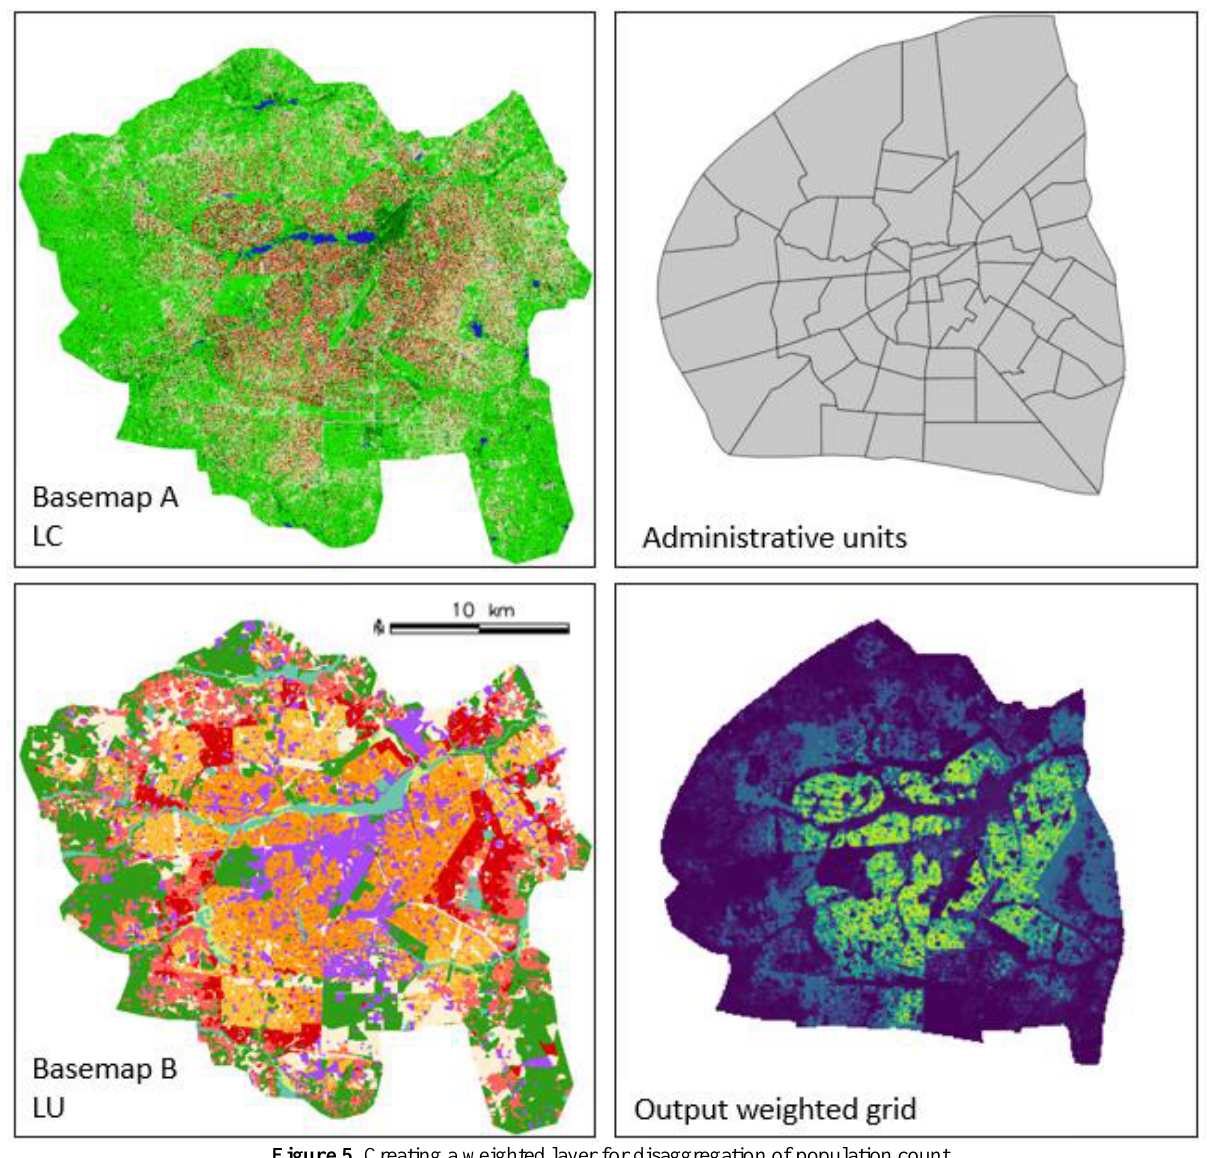
Figure 5 . Creating a weighted layer for disaggregation of population count